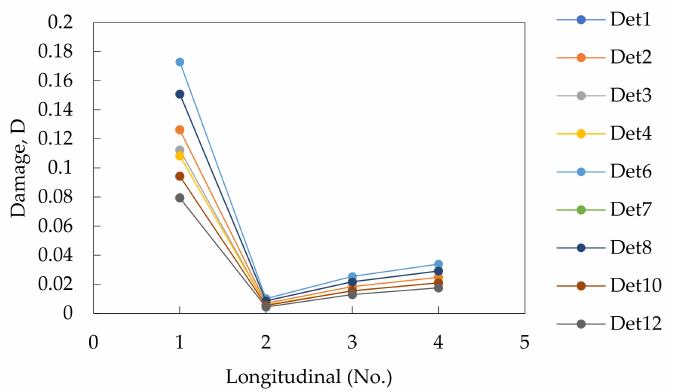
Figure 7. Comparative fatigue damage in combinations between side shell longitudinals ( L1 to L4 ) and structural details in the initial condition ( y 0 = 14.225 m and z 0 = 14.82 m).